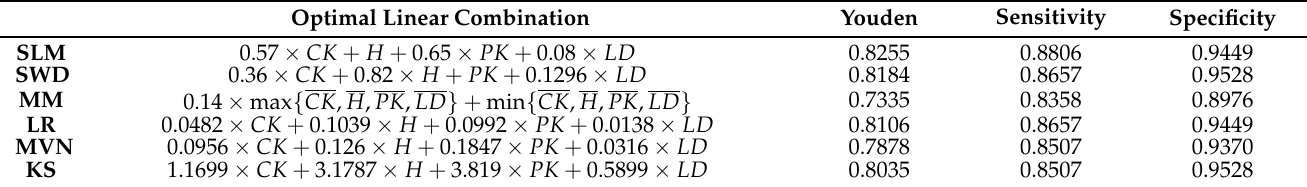
Table 20. Linear combination that maximizes the Youden index for each method. DMD dataset.